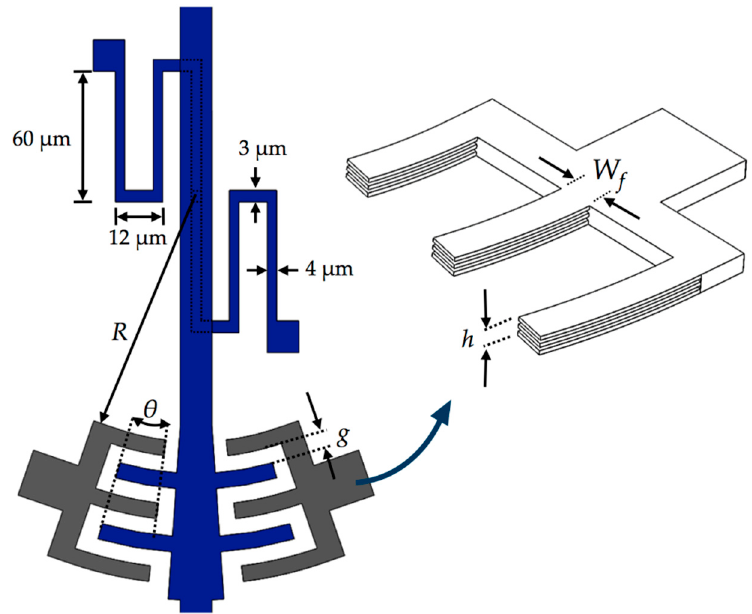
Figure 5. Schematic view of the electrodynamic actuators which are used to measure the capacitance shifts of the designed microgripper.